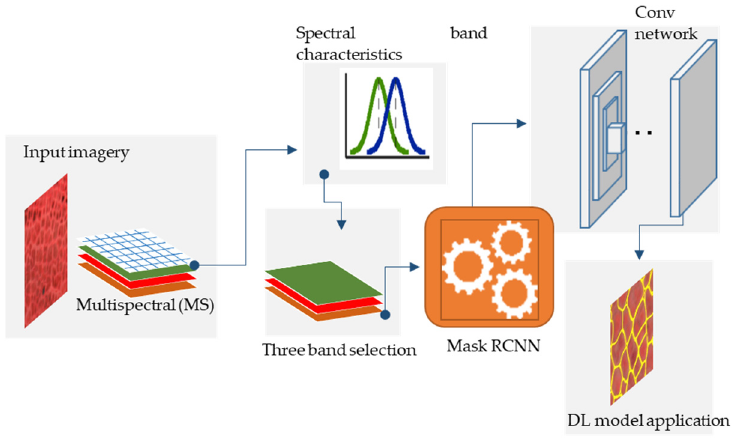
Figure 2. Simplified schematic of the automated ice wedge polygon mapping workflow.